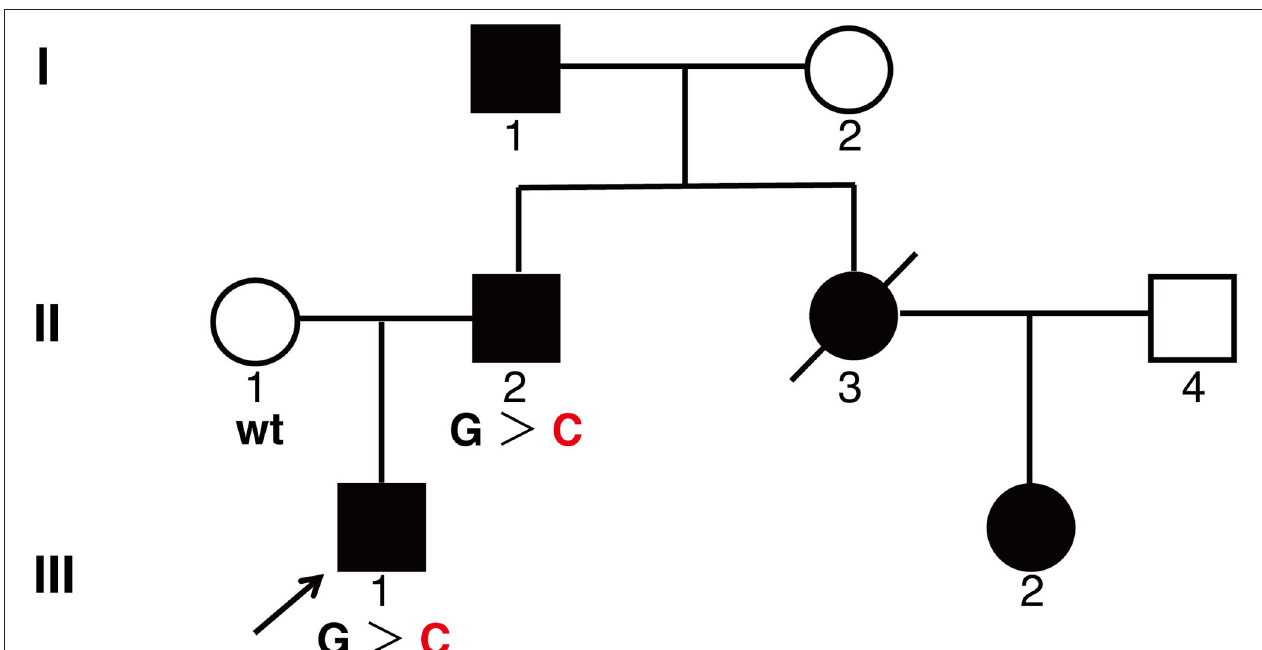
FIGURE 1 | A pedigree showing phenotypes of the family. Three family members were genotyped for KIT mutation. Affected men and women are indicated by filled squares and circles, respectively. A crossed symbol indicated a deceased individual due to urenia. An arrow head indicates the proband. wt, wild type; G > C, heterozygote of c.2485G >